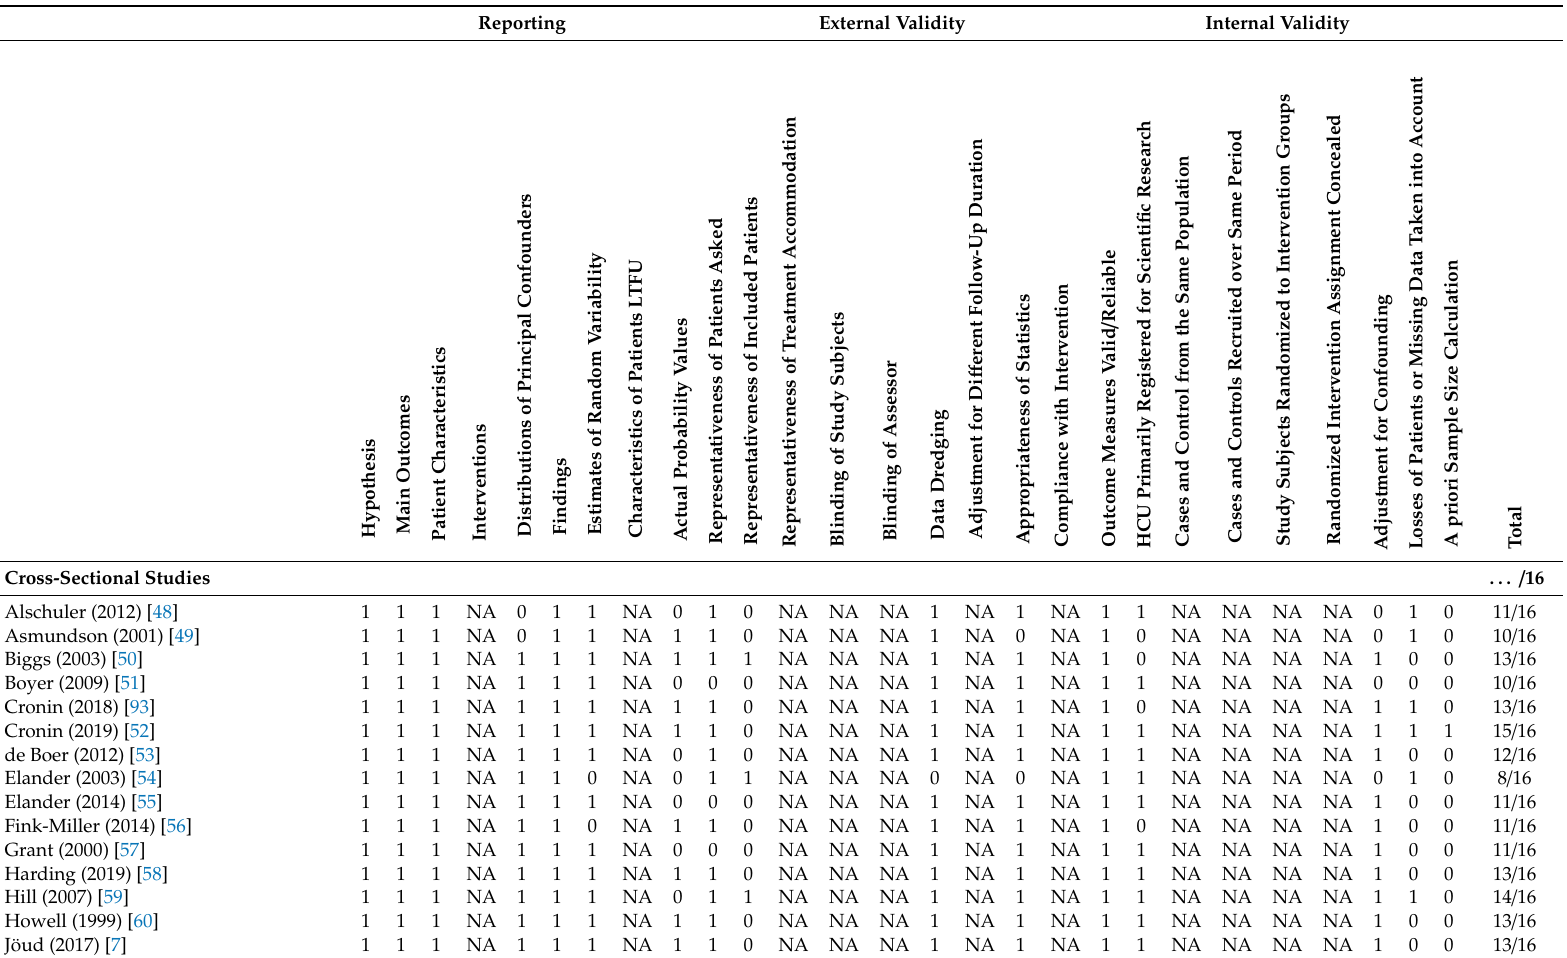
Table A3. Complete risk of bias assessment based on a modified version of the Downs and Black